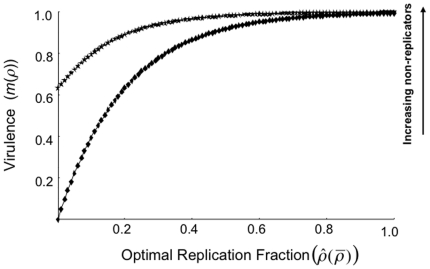
The role of non-replicating parasites on virulence (m(ρ)).Increases in the optimal replication fraction lead to increases in virulence and the presence of non-replicators can enhance virulence effects even if overall parasite fitness is restricted.